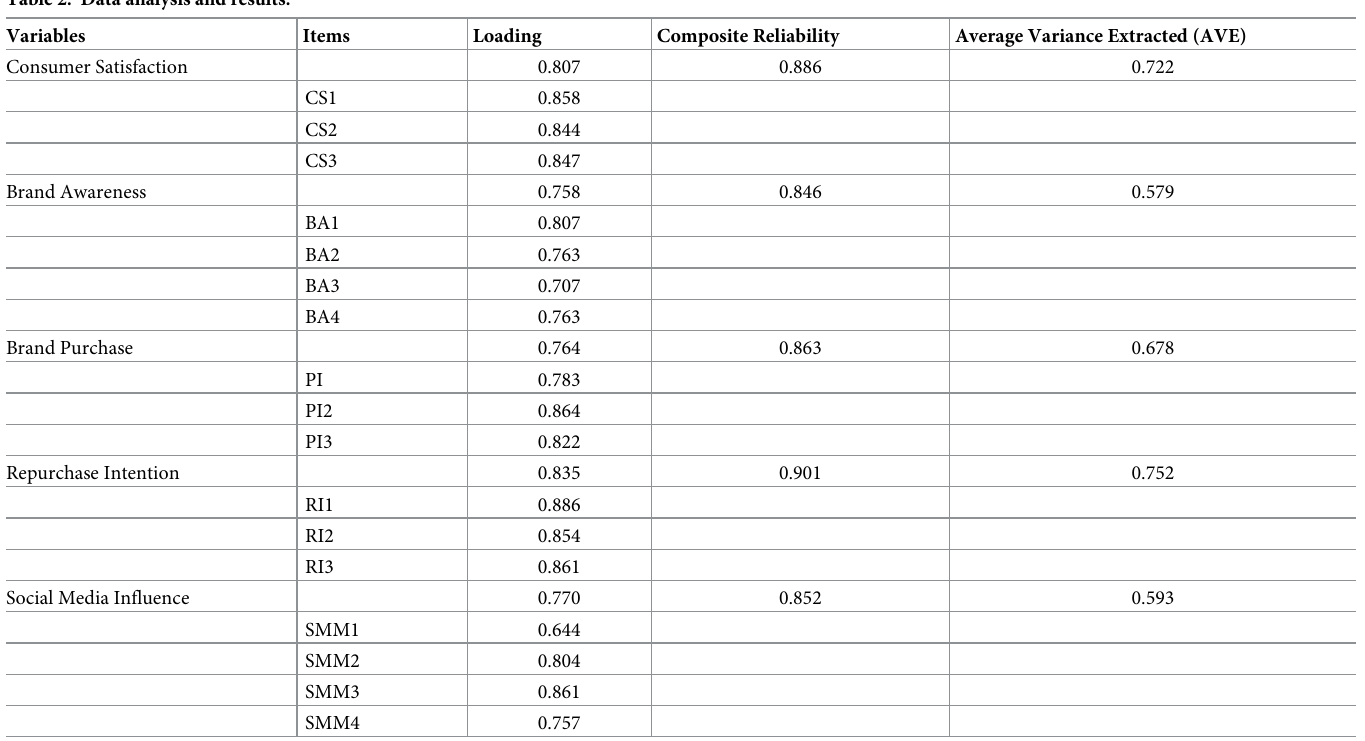
Table 2. Data analysis and results.